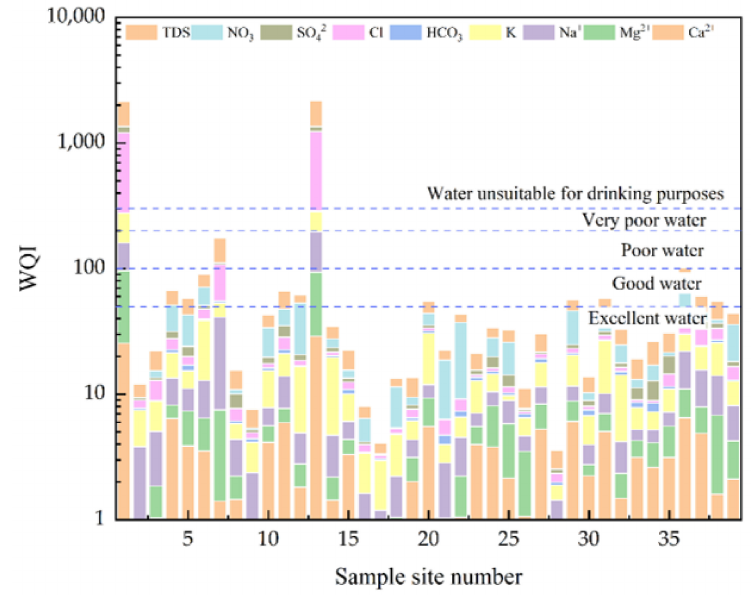
Figure 8. Bar graph of calculated WQI values in 39 groundwater samples (1–14: Shantou; 15–21: Yangjiang; 22–27: Zhujiang; 28–29: Huiyang; 30–31: Zhuhai; 32–35: Lufeng; 36–39: